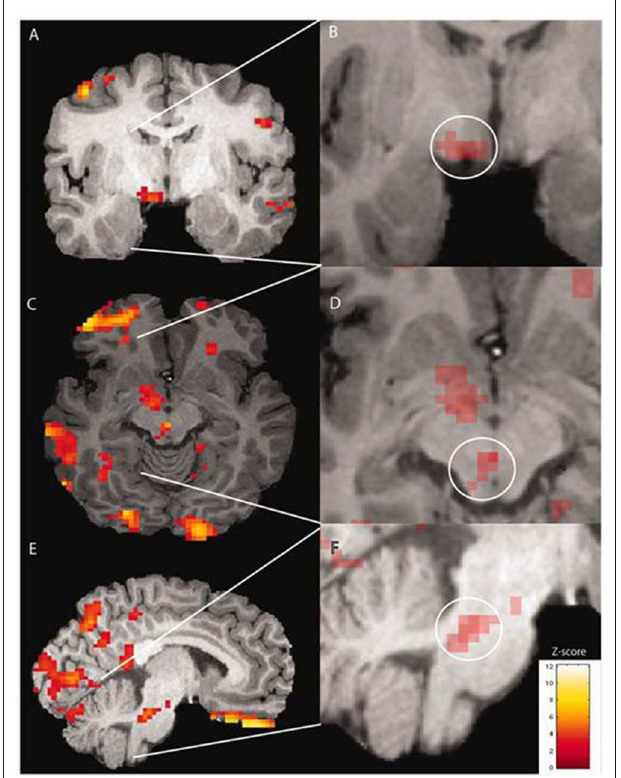
FIGURE 1 | Brain activations on PET imaging during the early premonitory phase of nitroglycerin-triggered migraine attacks, taken from Maniyar et al. ( 31)